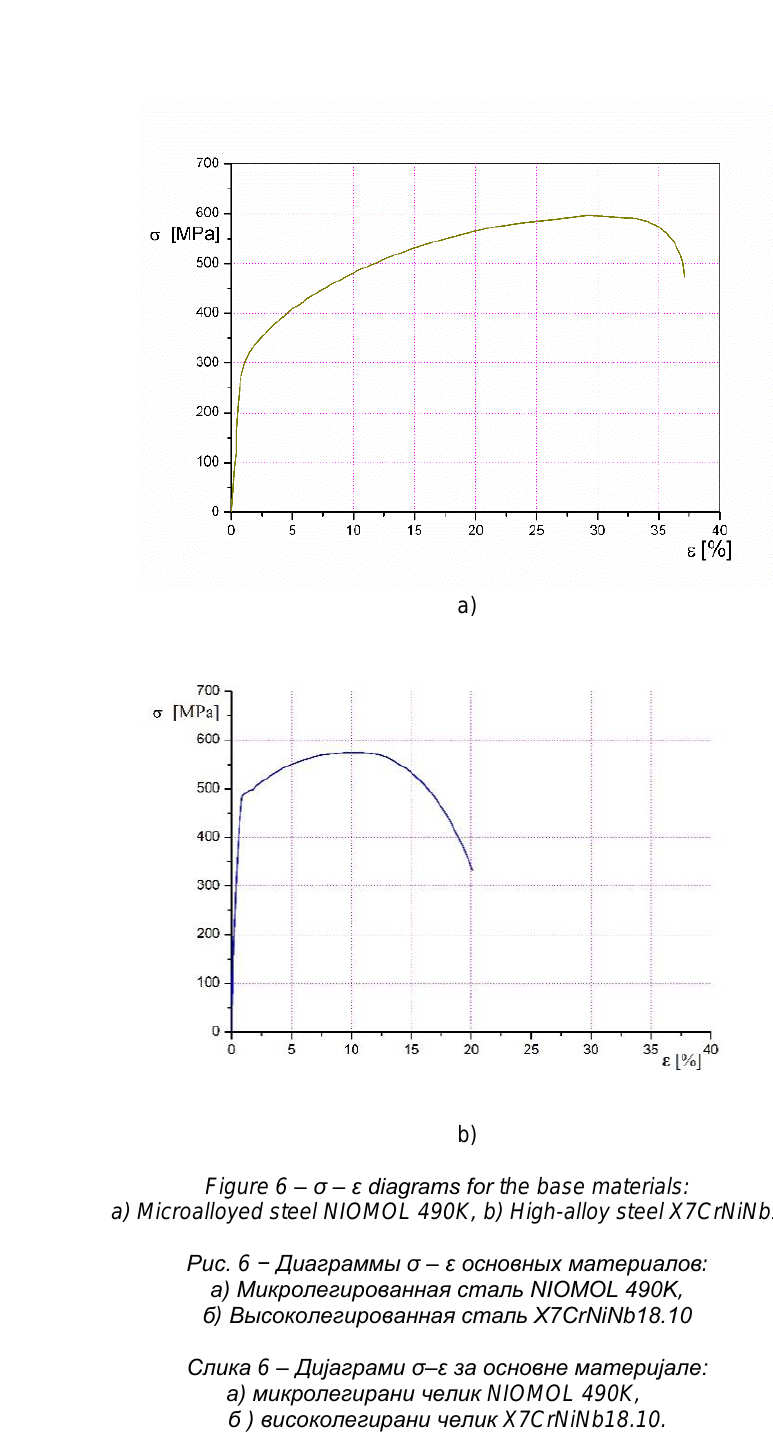
Figure 6 – σ – ε diagrams for the base materials: Рис. 6 − Диаграммы σ – ε основных материалов: а) Микролегированная сталь NIOMOL